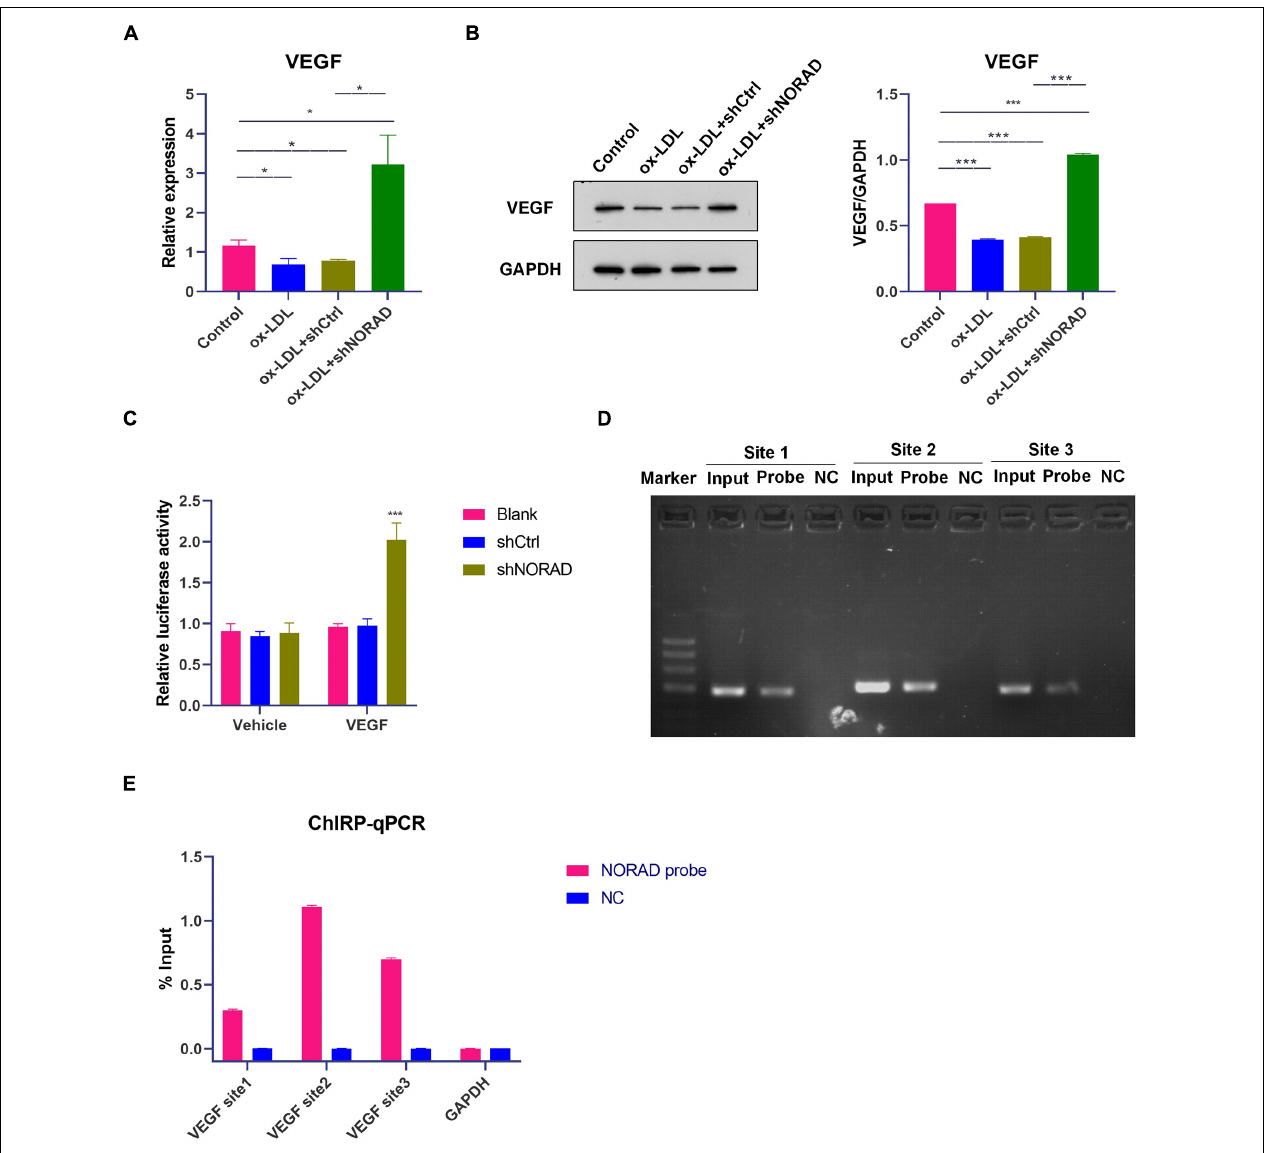
FIGURE 2 | Knockdown of lncRNA NORAD aggravates ox-LDL-reduced VEGF expression in HUVECs. (A) The mRNA level of VEGF in HUVECs (* p < 0.05). (B) The protein level of VEGF in HUVECs (*** p < 0.001). (C) VEGF gene promoter activity analyzed by relative luciferase reporter activities in HUVECs transfected with control shRNA or shRNA-targeting lncRNA NORAD (*** p < 0.001 vs. blank group). (D) Immunoprecipitated chromatin associated with lncRNA NORAD was analyzed using ChIRP followed by PCR for the VEGF gene promoter in HUVECs. (E) Quantification of lncRNA NORAD occupancy on the VEGF gene promoter by qRT-PCR in HUVECs. shRNA; shNORAD, shRNA-targeting lncRNA NORAD; NC, negative control. N =